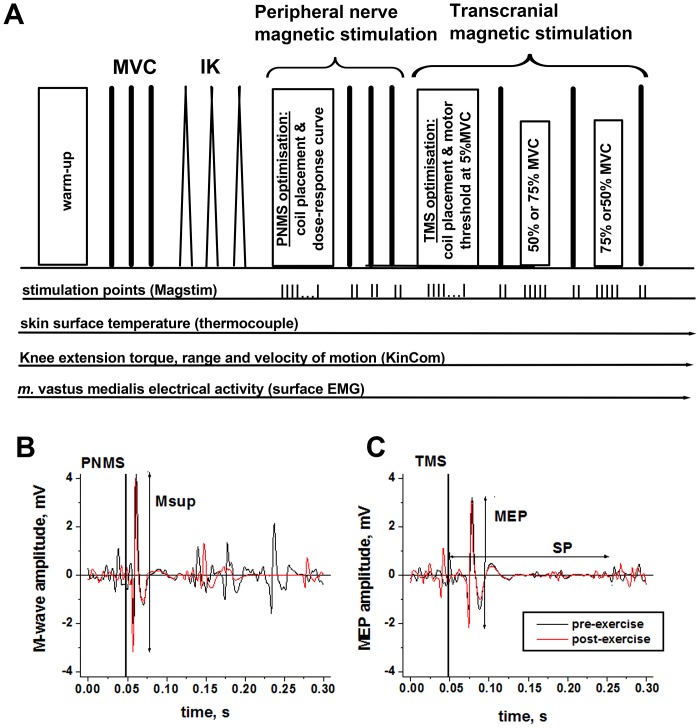
Experimental protocol.Schematic diagram of the experimental procedures and the recorded signals; MVC – maximal voluntary contraction; IK – isokinetic contraction (A); examples of the maximum compound muscle potentials (M-wave) evoked by peripheral nerve magnetic stimulation (PNMS) delivered to the femoral nerve (B) and the motor evoked potentials (MEP) evoked by transcranial magnetic stimulation (TMS) delivered to the motor cortex (C). The responses were recorded from the vastus medialis (VM) muscle of a representative participant during MVC pre and post-exercise; Msup – amplitude of the maximal M-wave; MEP – amplitude of the motor evoked potentials; SP – duration of the cortical silent period following the MEP.